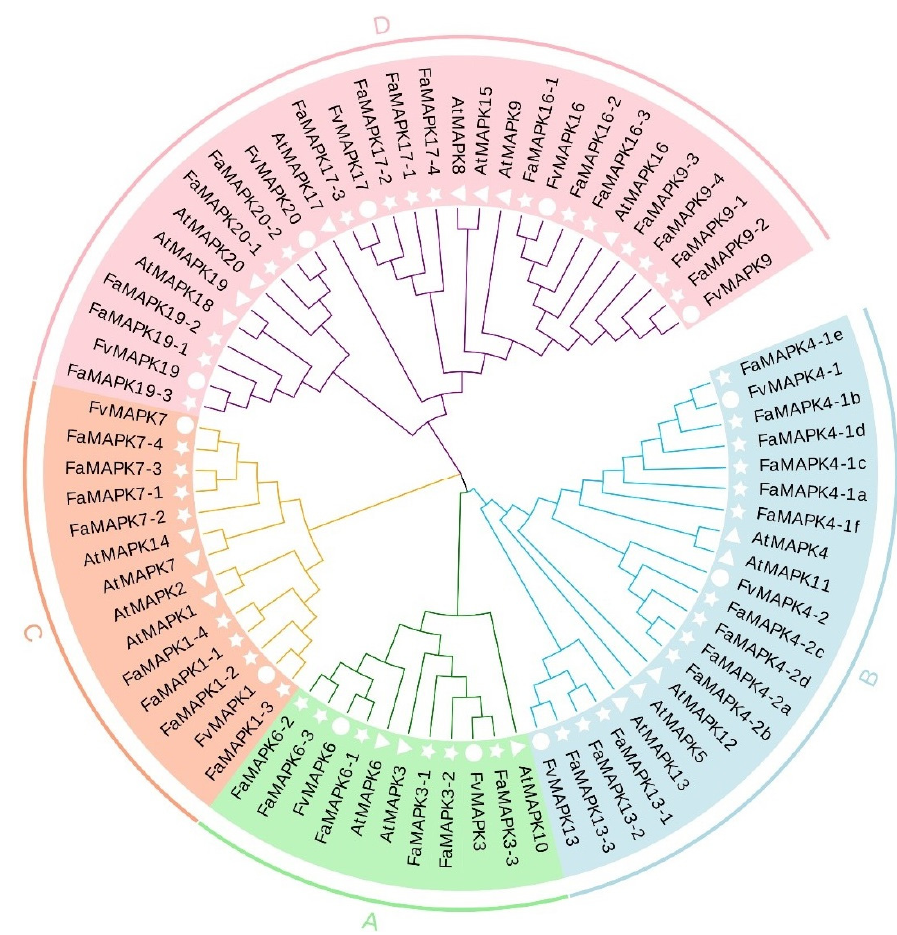
Figure 2. Phylogenetic tree of MAPK genes from Aradiopsis, F. vesca and F. × ananassa based on the amino acid sequences. Genes are grouped by different color blocks. The white triangles, circles and pentagrams indicated the MAPK genes in Arabidopsis thaliana (At); F. vesca (Fv); F. × ananassa (Fa).